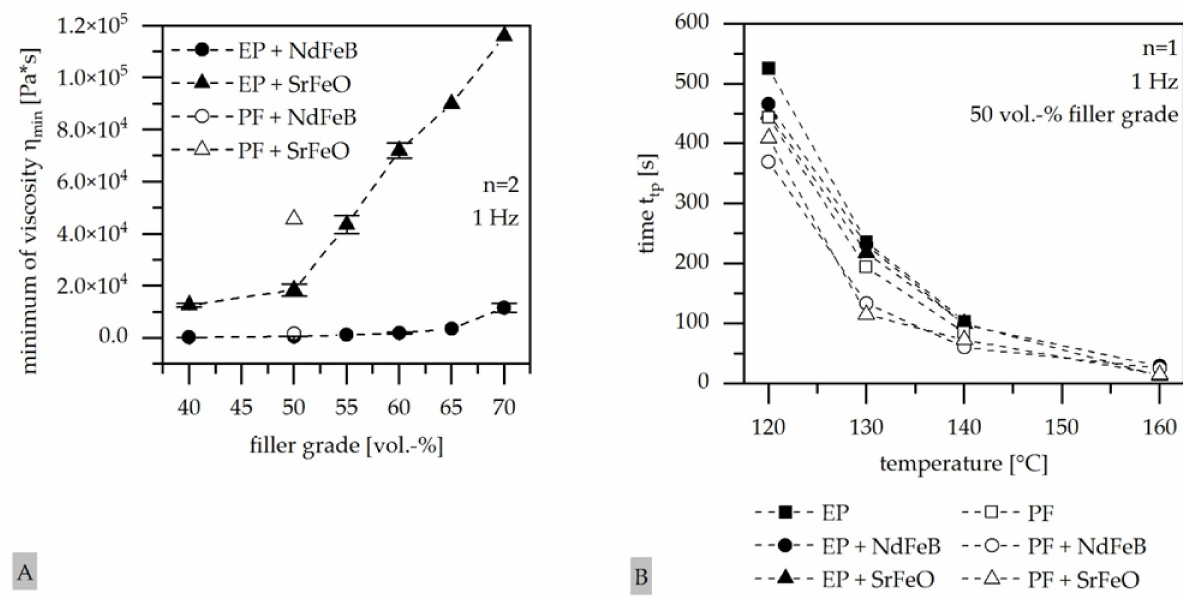
Figure 7. Minimum of viscosity η min ( A ) and time at turning point t tp relative to the temperature level ( B ) for different matrix materials, fillers and filler grades (SrFeO: strontium-ferrite-oxide; NdFeB: neodymium-iron-boron; PF: phenolic resin; EP: epoxy